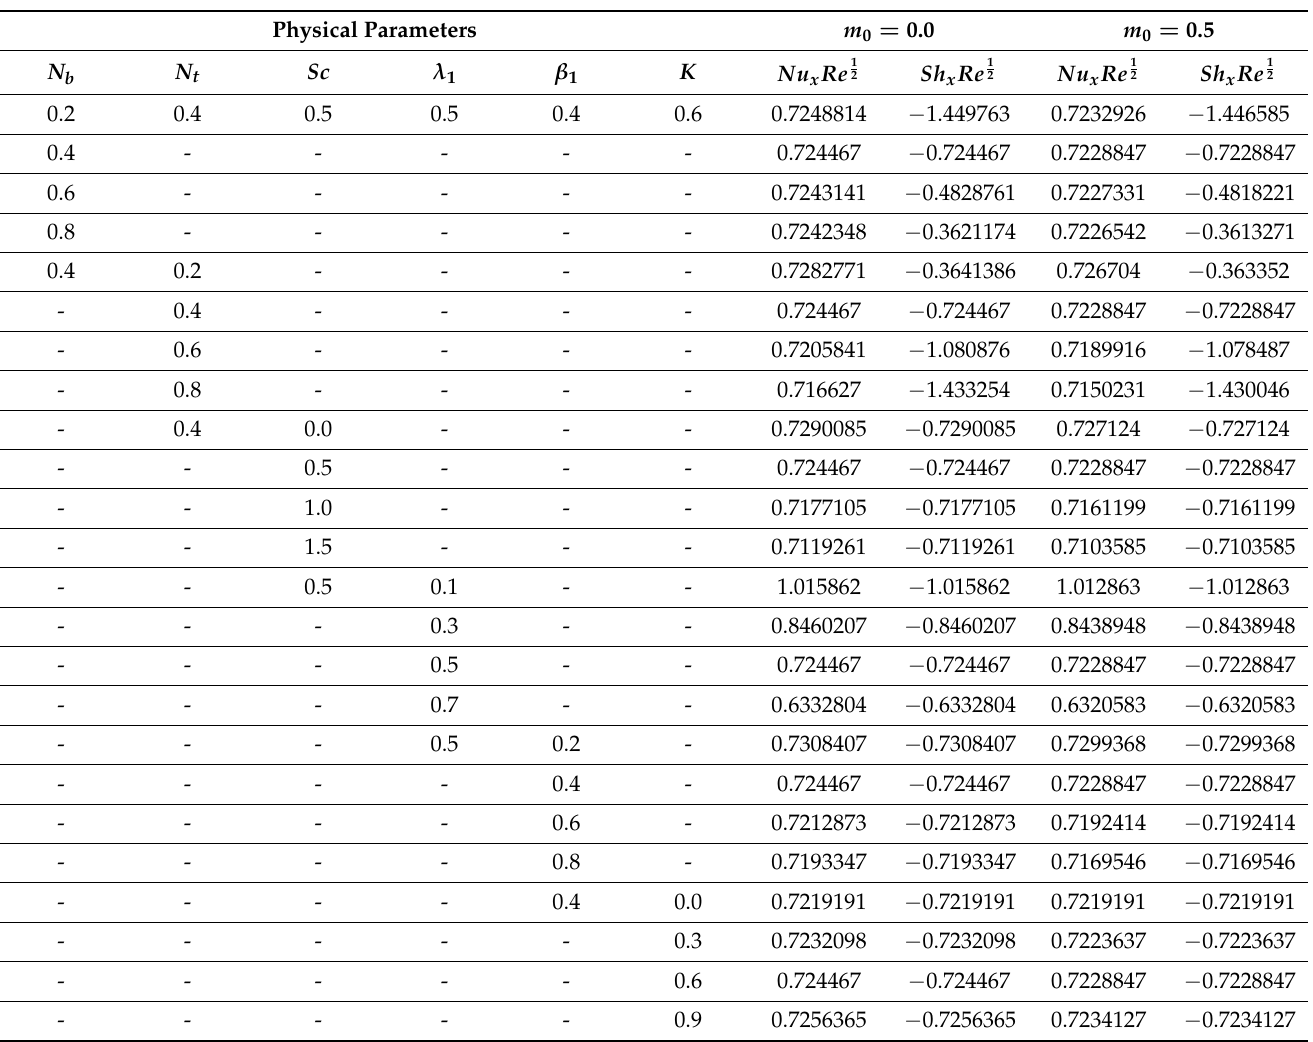
Table 2. Numerical results of the Sherwood number and Nusselt number for different values of